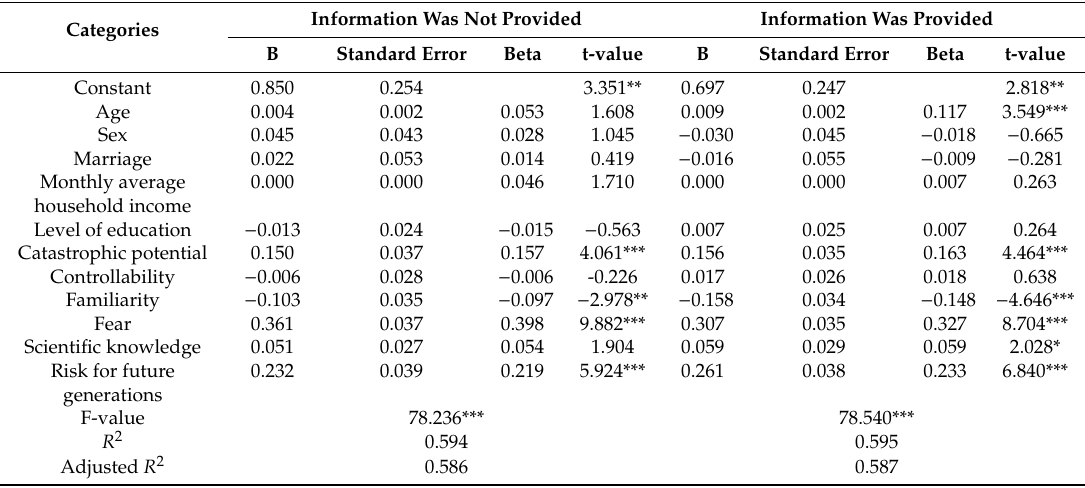
Table 4. Factors influencing risk perception based on the provision of safe usage